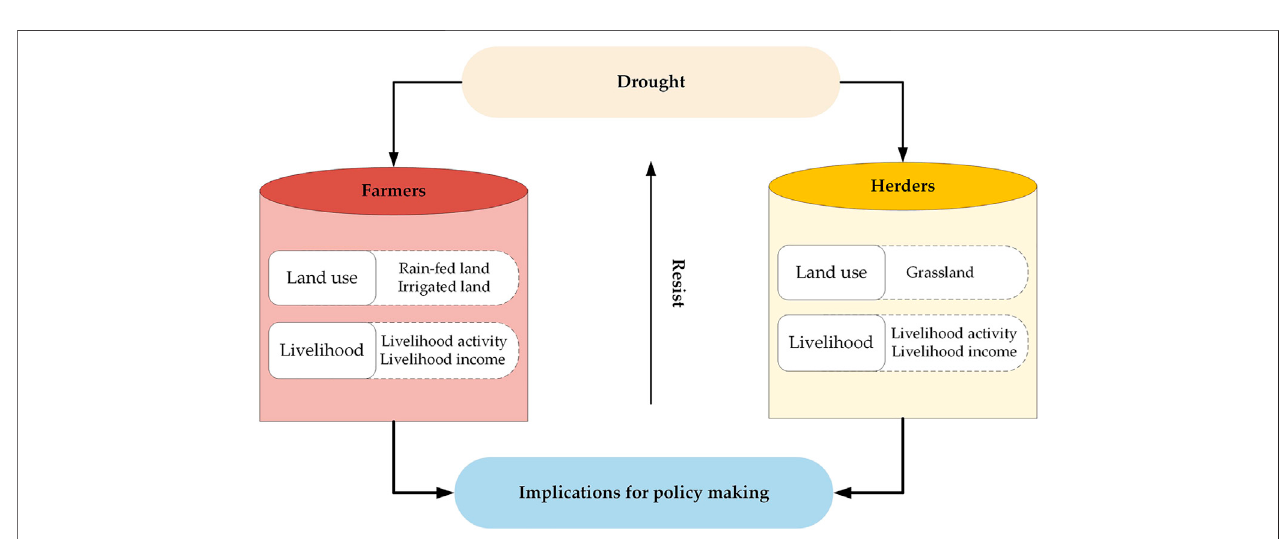
FIGURE 1 | Location of the study area.